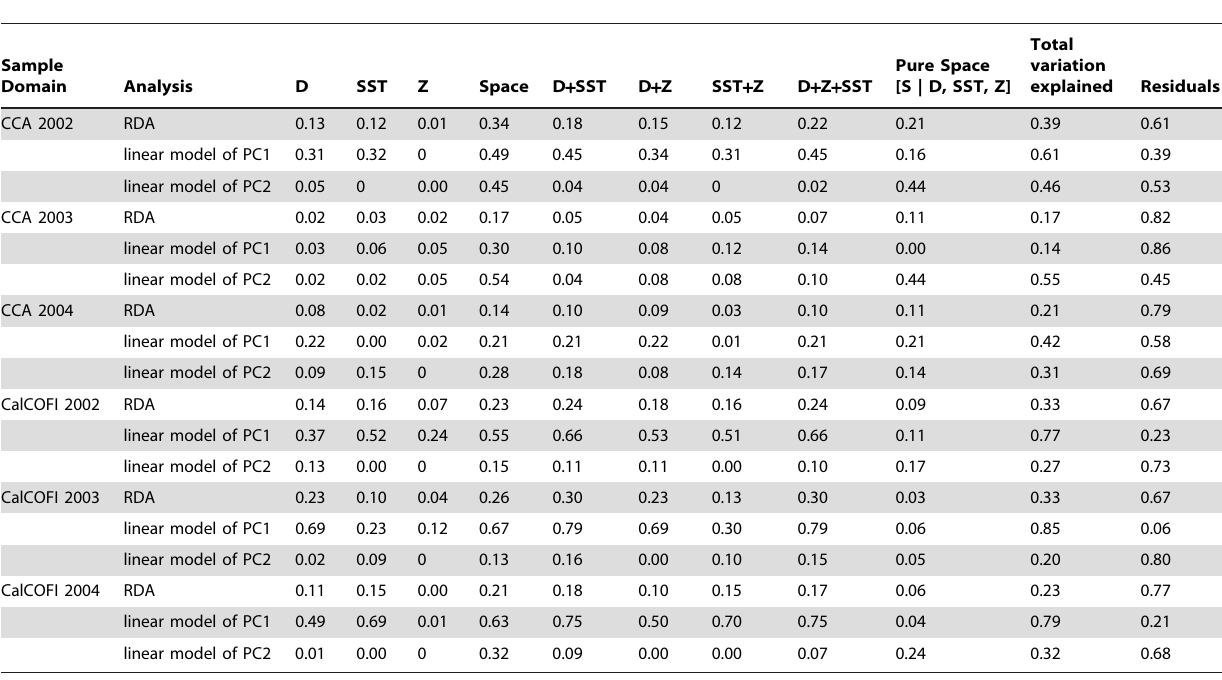
Table 4. Adjusted R 2 values from partitioning of the amount variation explained by depth (D), sea surface temperature (SST), zooplankton volume (Z) and PCNM eigenvectors (space) for intraannual analysis at the CCA and CalCOFI scales in each sample